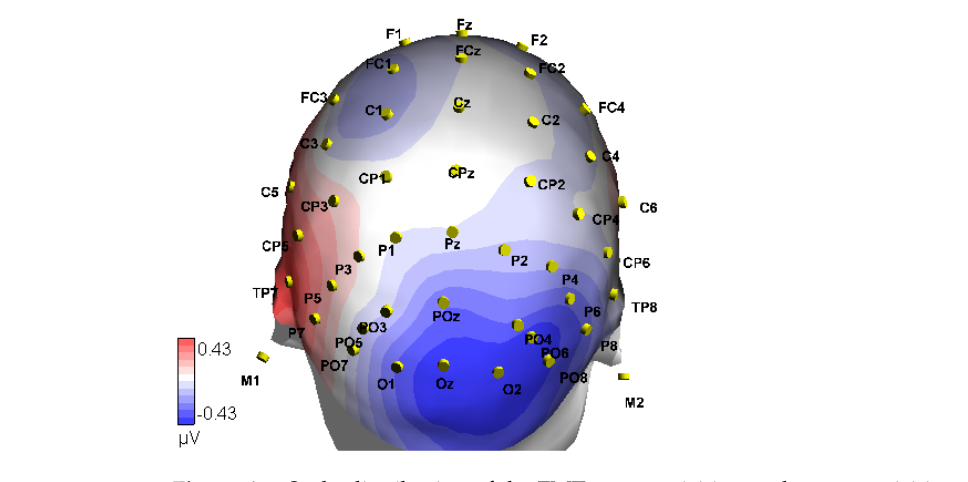
Figure A3. Scalp distribution of the FMT pre-acquisition and post-acquisition differential activity (pre–post) for those in the ADHD group. Latency coincides with that of the sLORETA results in the manuscript.